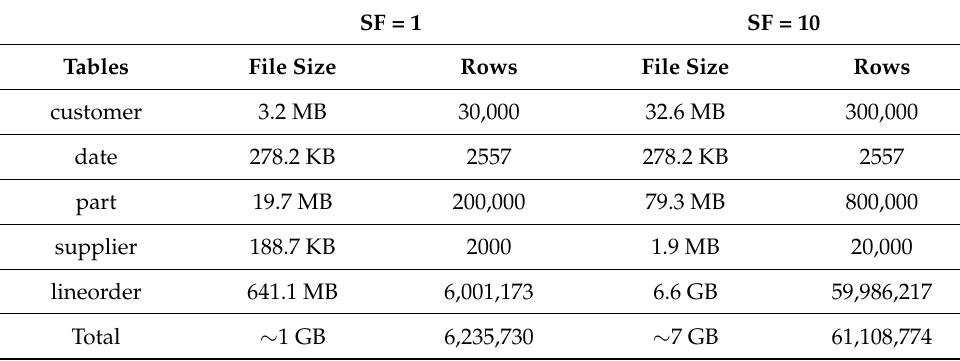
Table 5. File size and data import with SF = 1 and SF =